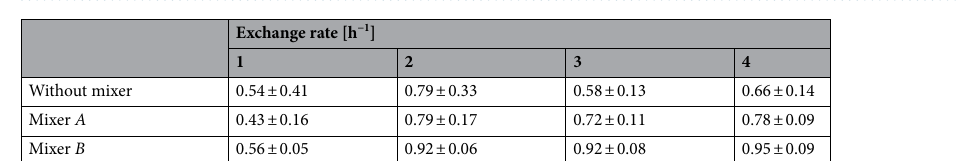
Table 2. Average and standard deviation of concentrations measured at five sampling points normalized by the theoretical concentration (without a mixer and with Mixers A and B ).